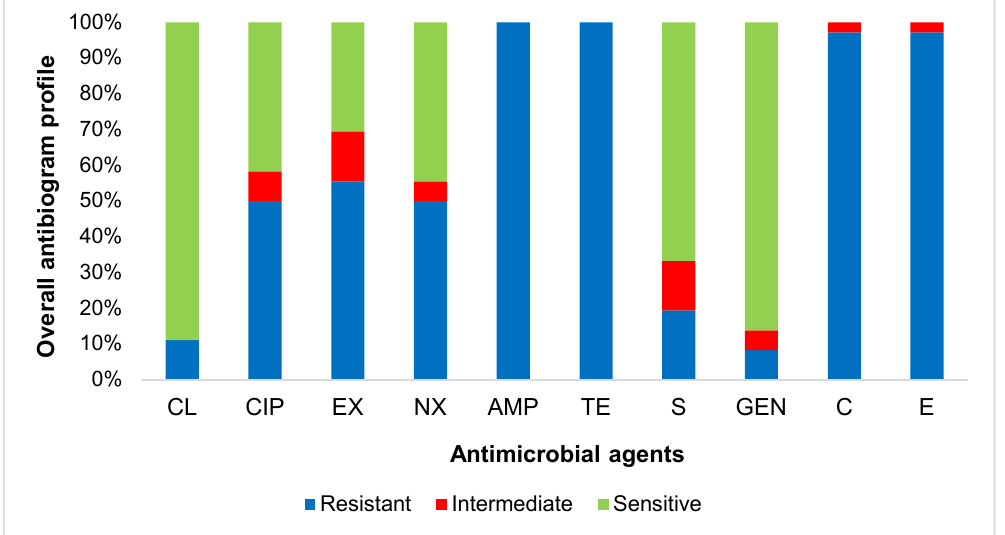
Figure 1. Overall antibiogram profile of the isolated APEC. CL, Colistin; CIP, Ciprofloxacin; EX, Enrofloxacin; NX, Norfloxacin; AMP, Ampicillin; TE, Tetracycline; S, Streptomycin; GEN, Gentamicin; C, Chloramphenicol; E, Erythromycin.